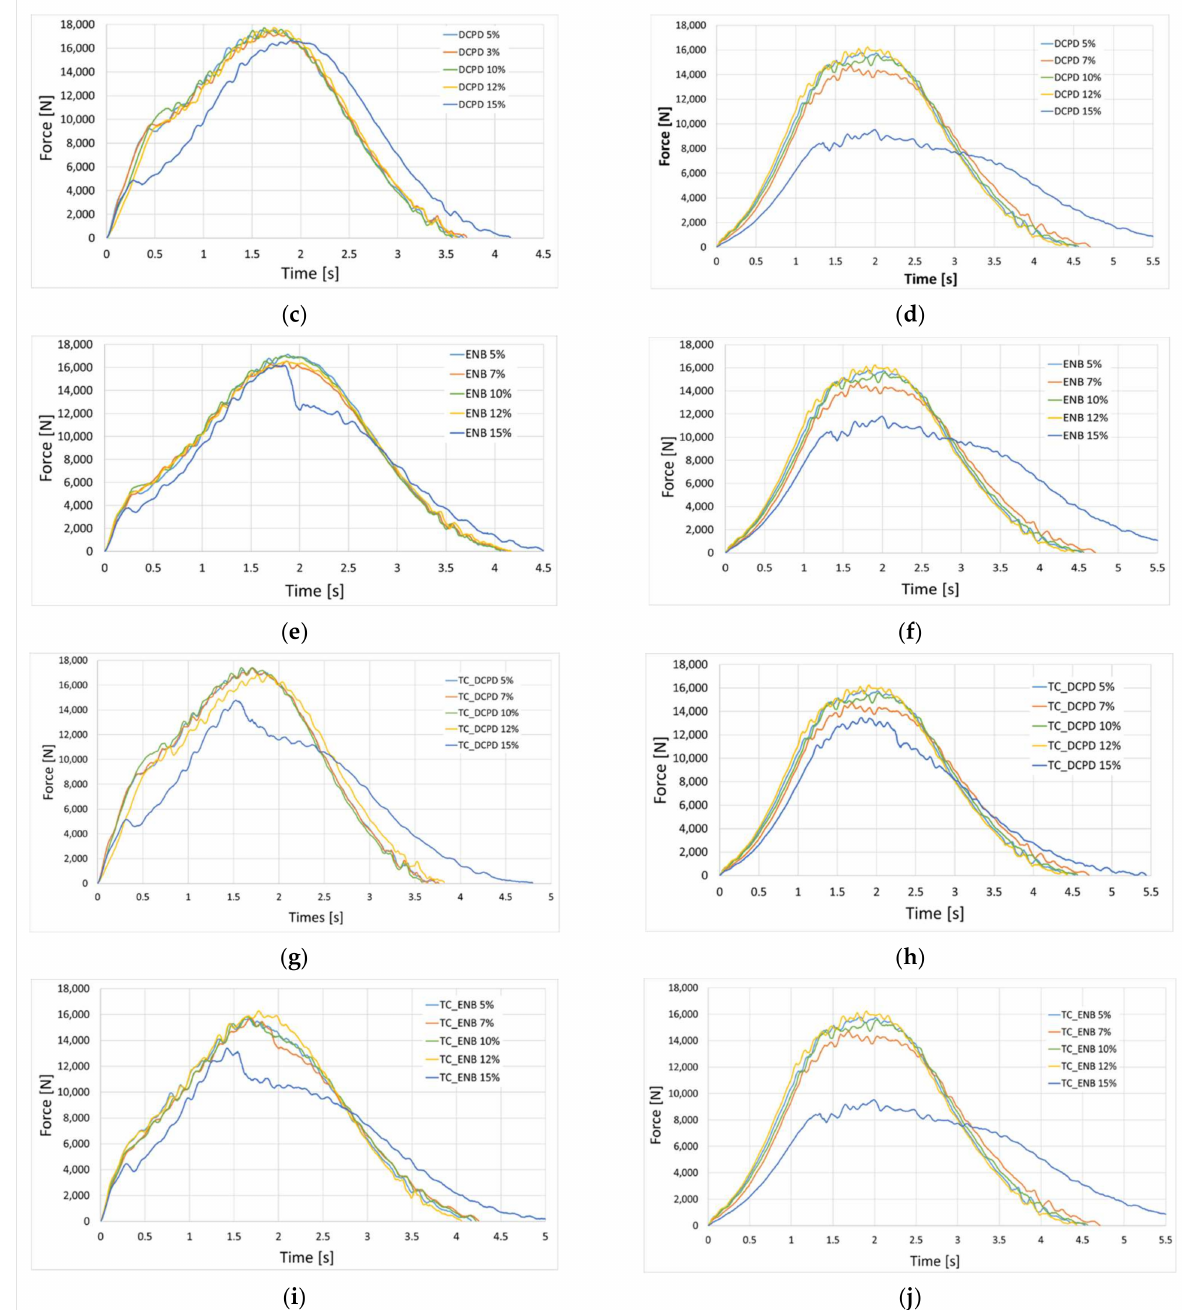
Figure 9. Impact test results after first and second test for ( a , b ) reference, ( c , d ) PUF-DCPD, ( e , f ) MUF-ENB, ( g , h ) PUF-DCPD after thermal cycling and ( i , j ) MUF-ENB after thermal cycling